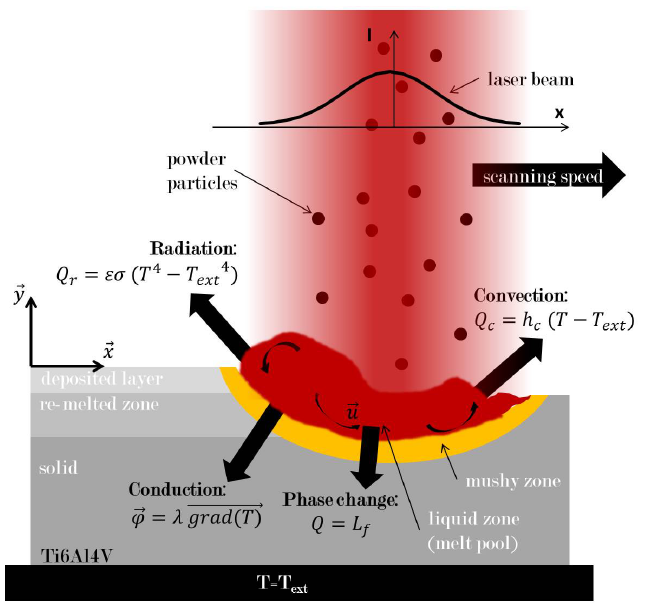
Figure 1. Heat transfer and configuration of the DMD